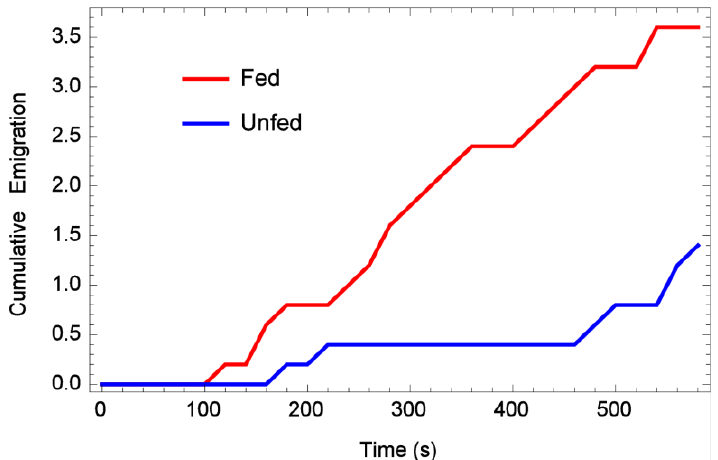
Figure 6. Mean cumulative emigration rates over time (bugs that reached the edge), two-dimensional arena.